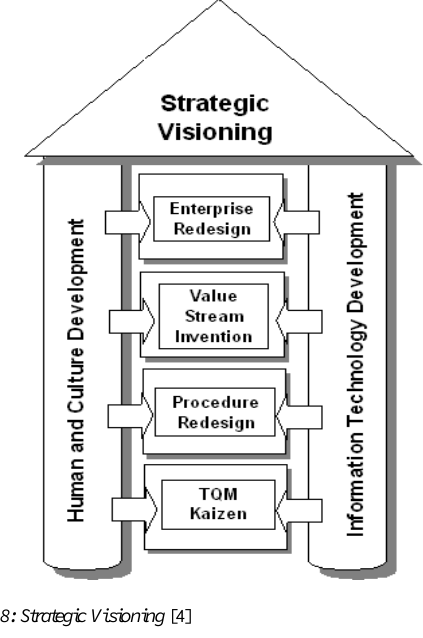
Figure 8: Strategic Visioning [4]